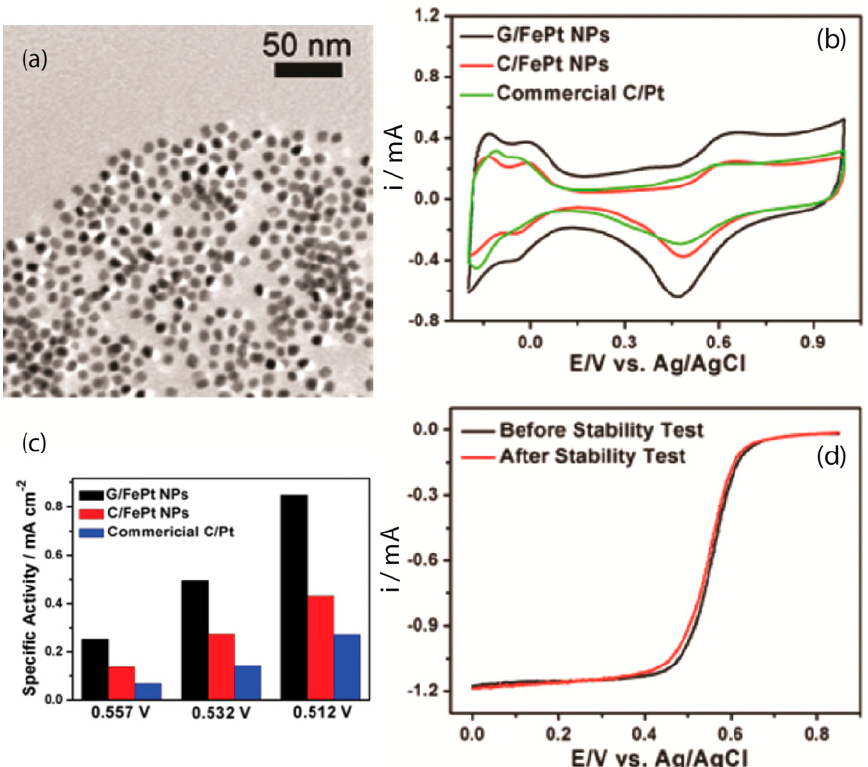
Figure 1. ( a ) TEM image of the Fe 58 Pt 42 NPs assembled on the graphene surface. ( b ) Cyclic